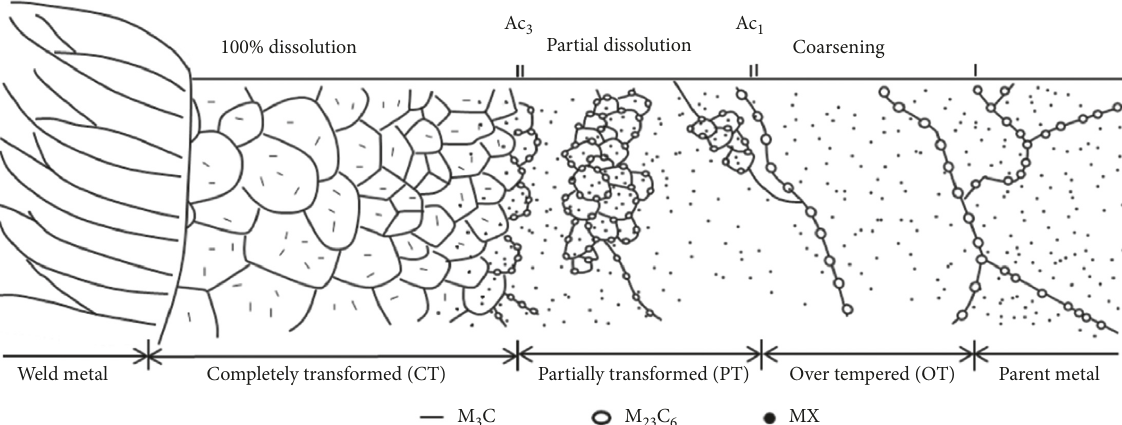
Figure 3: Schematic diagram illustrating the microstructural regions in the heat-affected zone of a fusion weld in a tempered martensitic steel [6, 7]. Meaningful characterization of microstructure in 9% Cr CSEF steels should take into account the phase dissolution and transformation behavior rather than simply describing the regions in the HAZ based on the size of the prior austenite